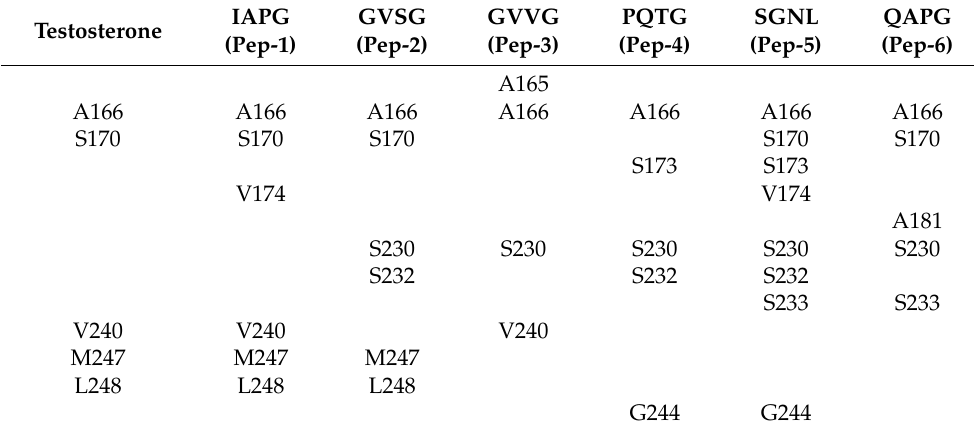
Table 3. Coordination Residues (human ZIP9). A166 is the only amino acid that interacts with all